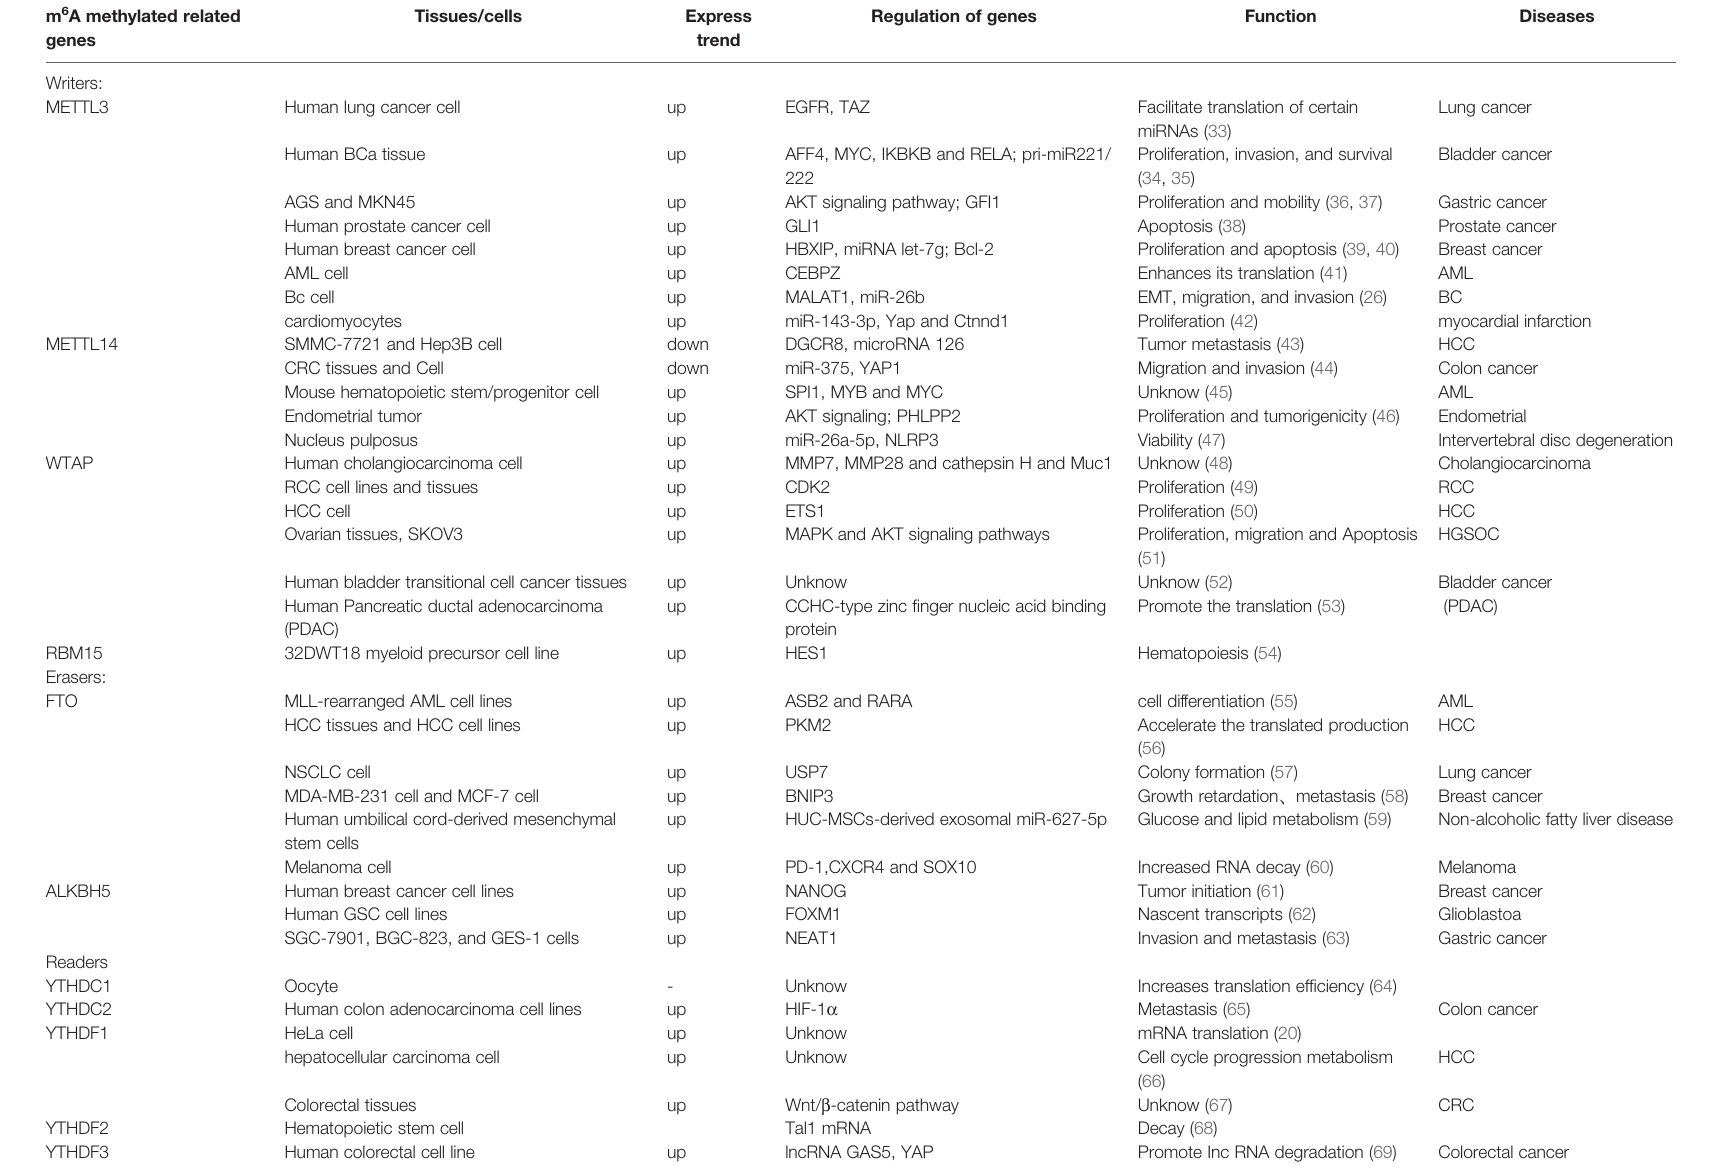
TABLE 1 | m 6 A methylation related to